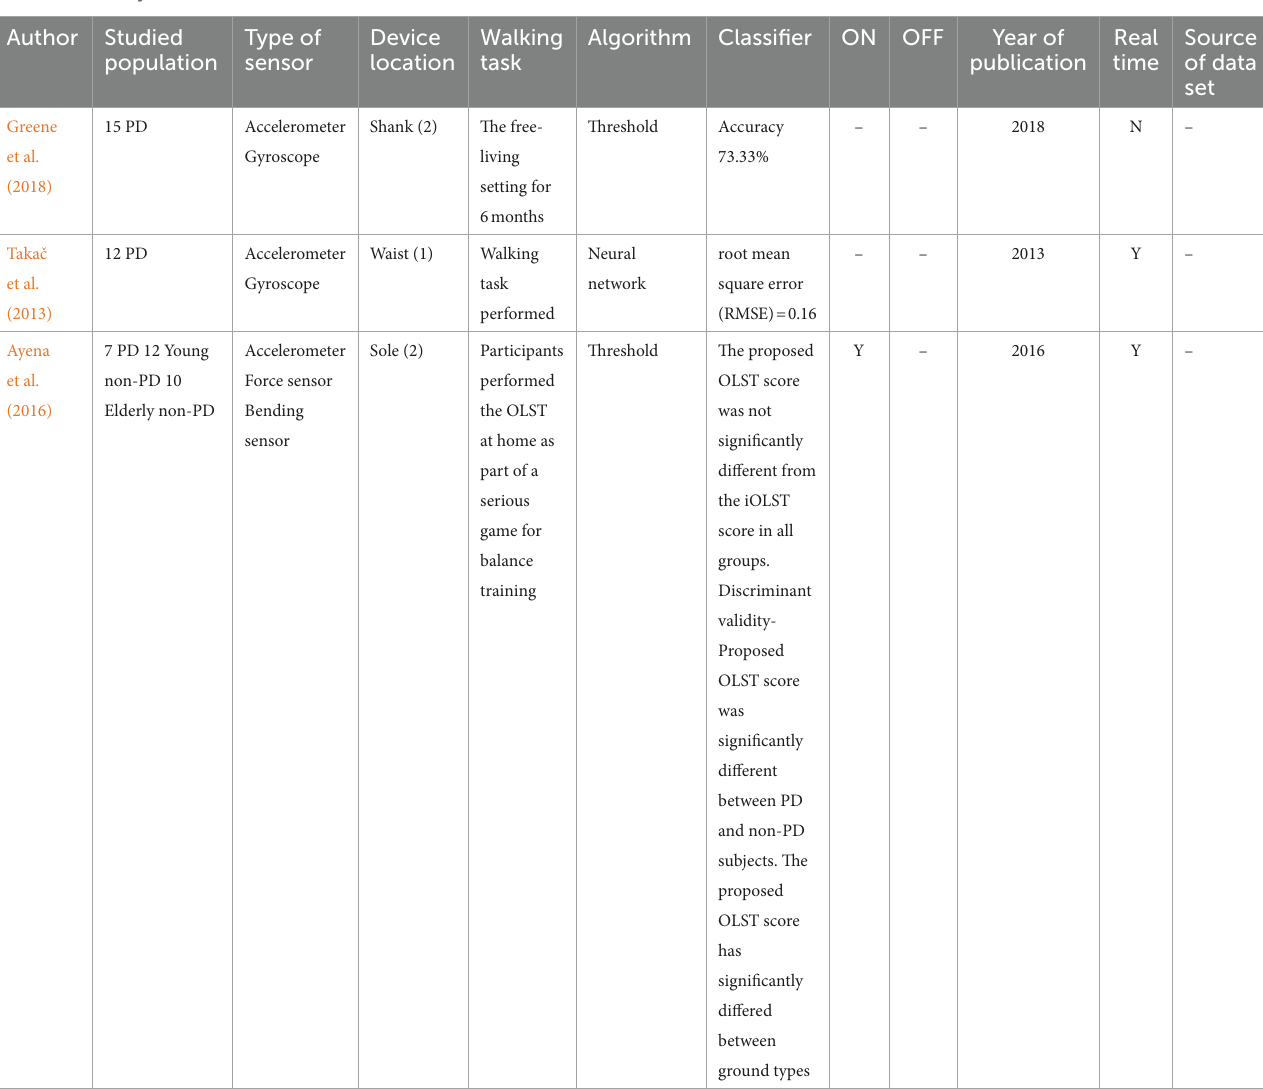
TABLE 5 Summary of fall detection